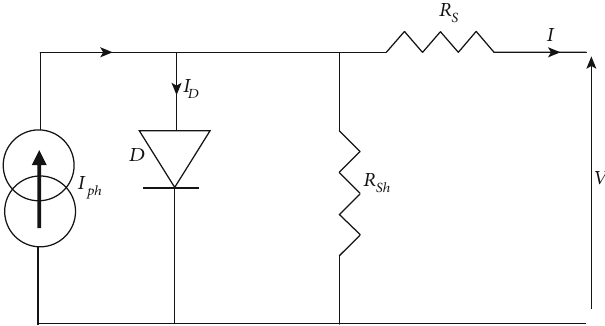
Figure 1: Representation of the solar cell model with a single diode.